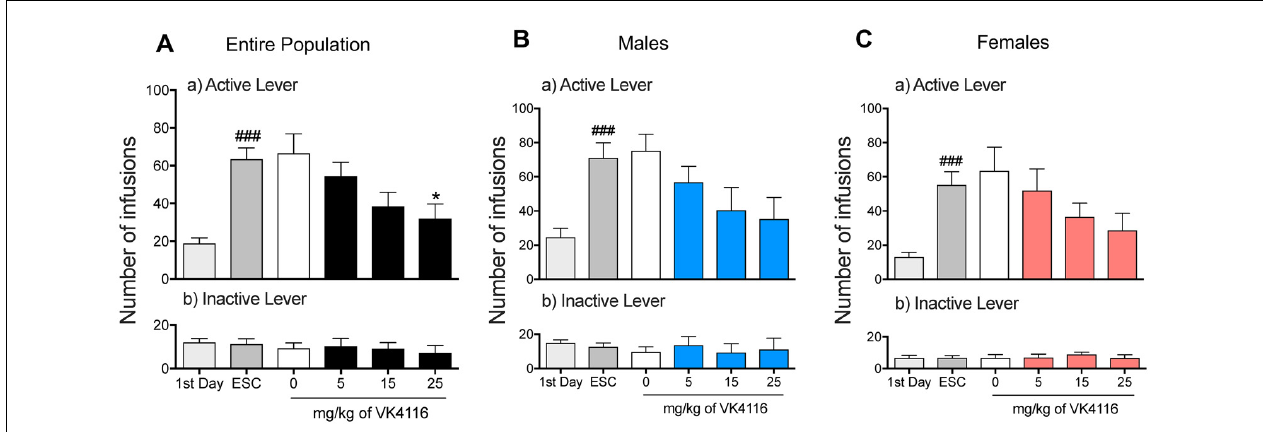
FIGURE 2 | (A) Effect of VK4116 on the escalation of oxycodone self-administration in HS rats. (B) Effect of VK4116 on the escalation of oxycodone self-administration in male HS rats. (C) Effect of VK4116 on the escalation of oxycodone self-administration in female HS rats. The upper panels (a) represent responses at the active lever. The lower panels (b) represent responses at the inactive lever. ∗ p < 0.05, vs. 0 mg/kg; ### p < 0.001, vs. first day of oxycodone self-administration.